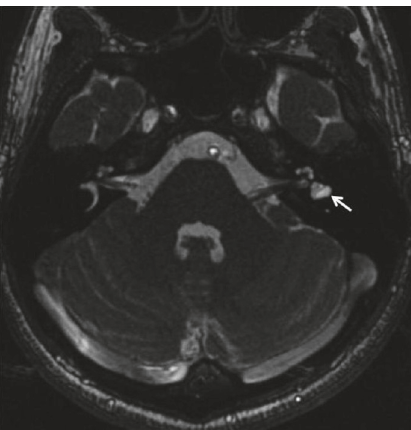
Figure 1: MRI of the patient showing a malformation of the left horizontal semicircular canal and vestibule forming a vestibular common cavity, compatible with the concept of lateral semicircular canal vestibule dysplasia